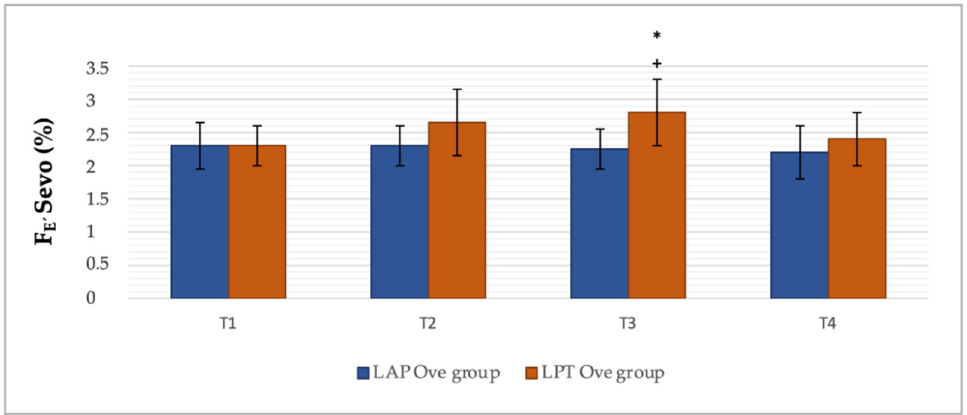
Figure 3. Percentage of end-tidal sevoflurane concentration (F E’ Sevo) at different points in time along the experimental period. Values given as a mean ± SD . p < 0.05: * vs. the LAP Ove group at the same time; + vs. T1 within the same Ove group.